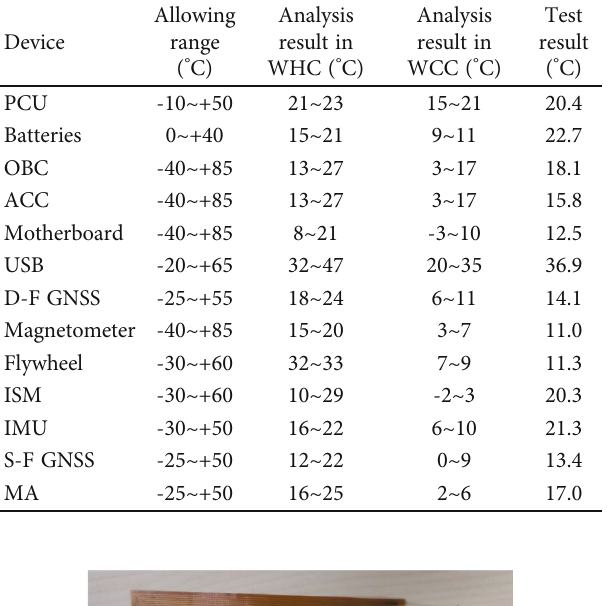
Figure 7: The core temperature distribution of thermal analysis. Table 4: Temperatures of devices inside Q-SAT.